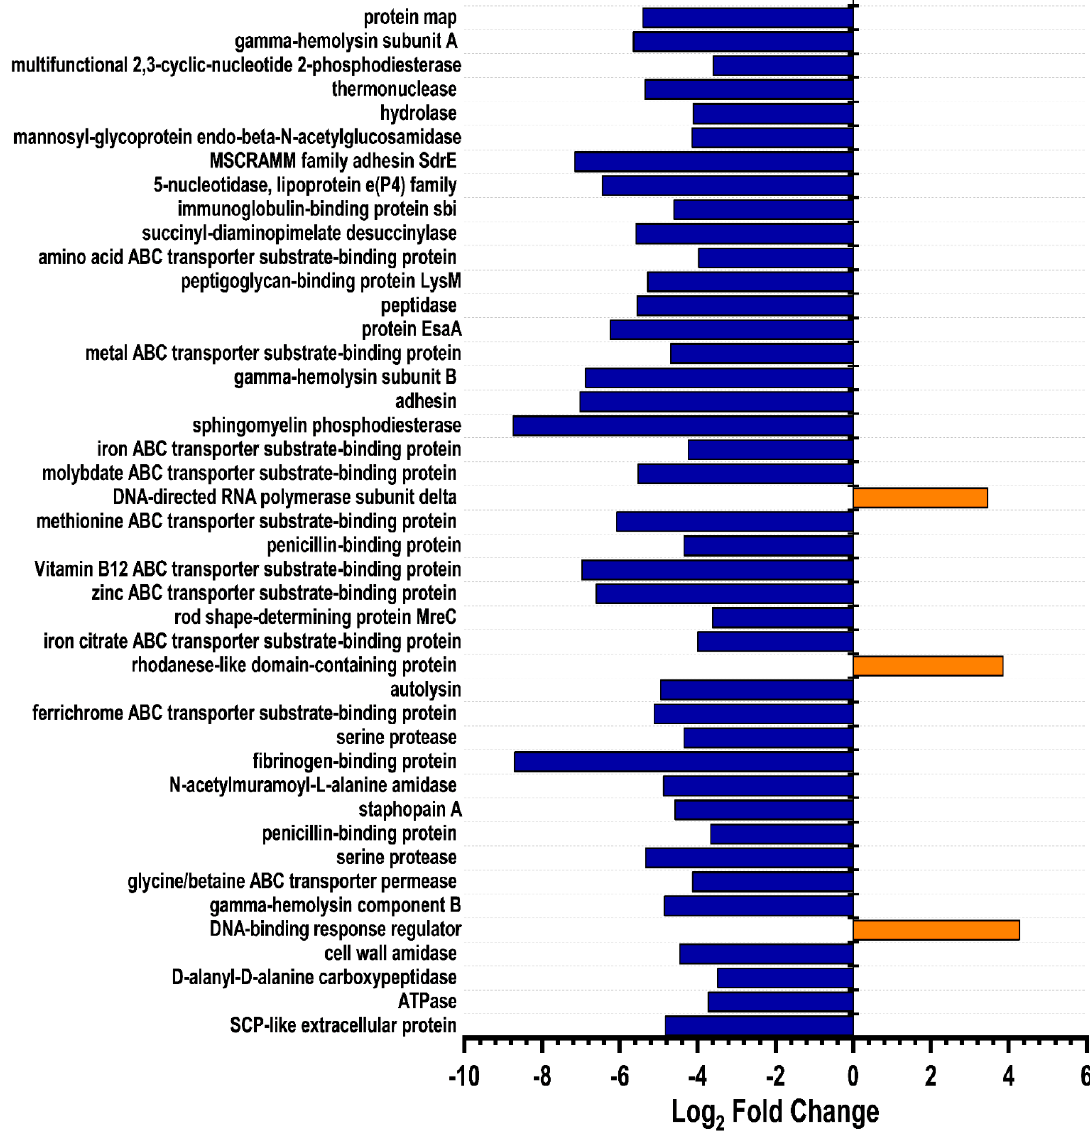
Figure 10. S. aureus ATCC 25923 proteins regulated by a log 2 fold greater than 3 in response to HSN584 treatment. Table 3. Control group unique proteins.